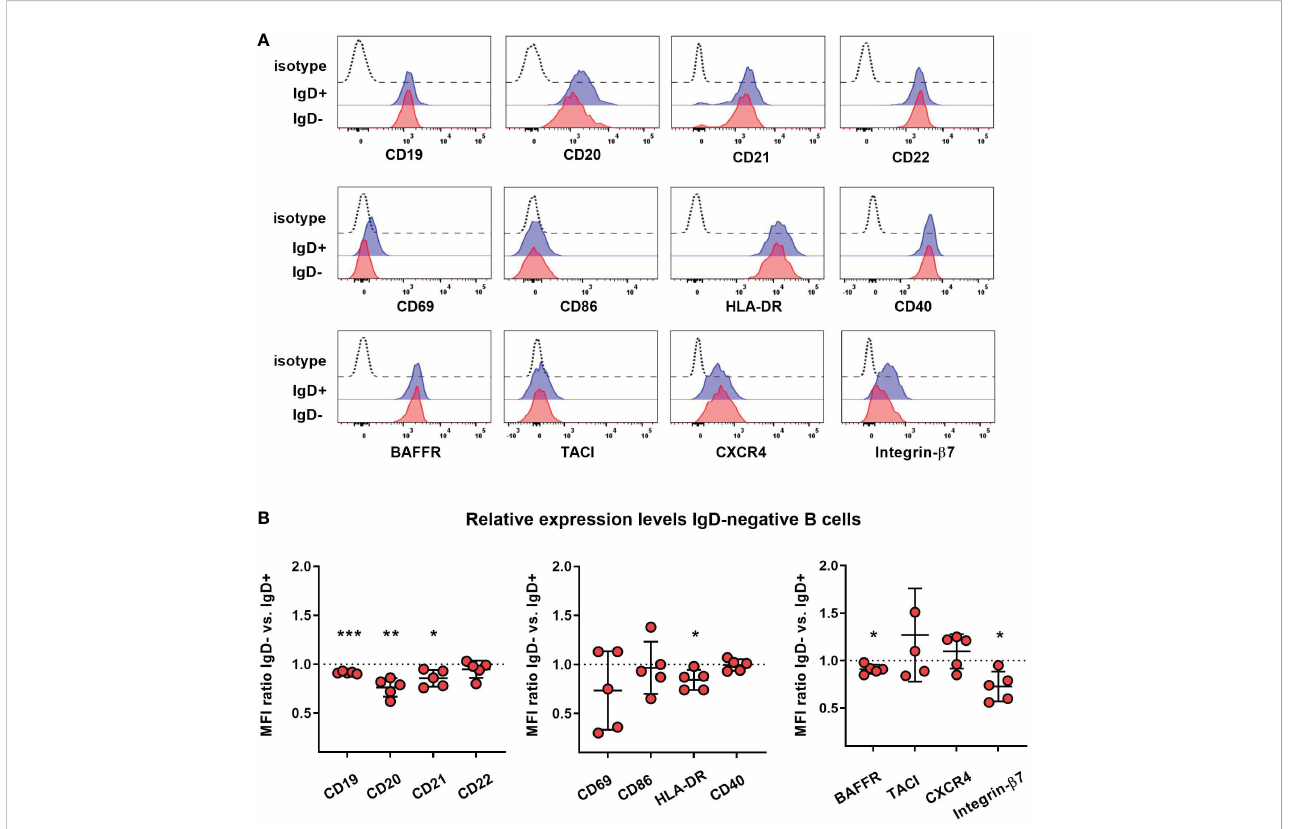
FIGURE 4 Reduced expression of co-stimulatory molecules on IgD-negative naïve B cells (A) Representative histograms obtained from fl ow cytometric analysis of IgD + (blue line) or IgD - (red line) CD19 + CD27 - IgM + naïve B cells from an individual carrying a heterozygous IGHD variant showing expression of different markers. Dashed lines represent isotype control. (B) Relative expression levels of each marker within 5 different individuals carrying heterozygous IGHD variants is shown as IgD + /IgD - ratio (mean fl uorescence intensity, MFI; *, p < 0.05; **, p < 0.01; ***, p < 0.001 one sample t-test with hypothesized mean of